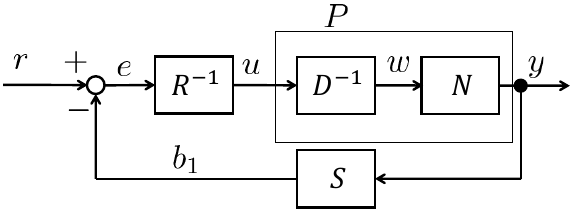
Figure 9. Operator-based